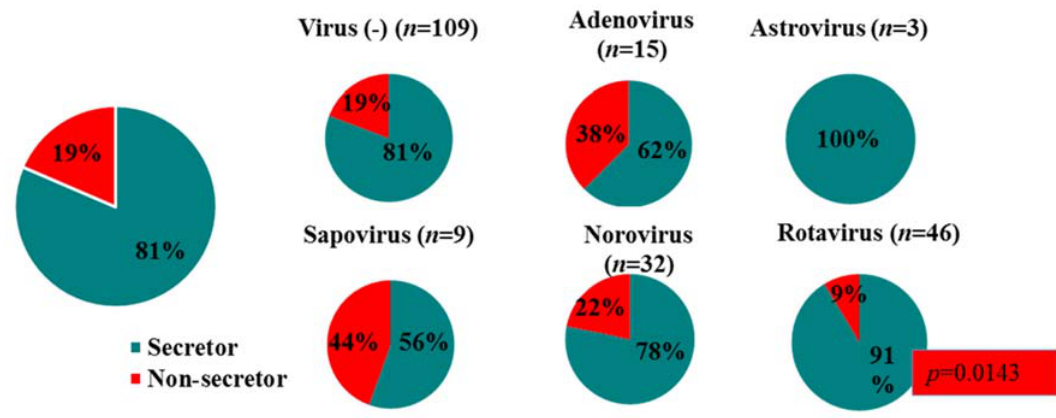
Figure 8. Secretor/non-secretor ratios for children infected with the different gastroenteritis viruses.